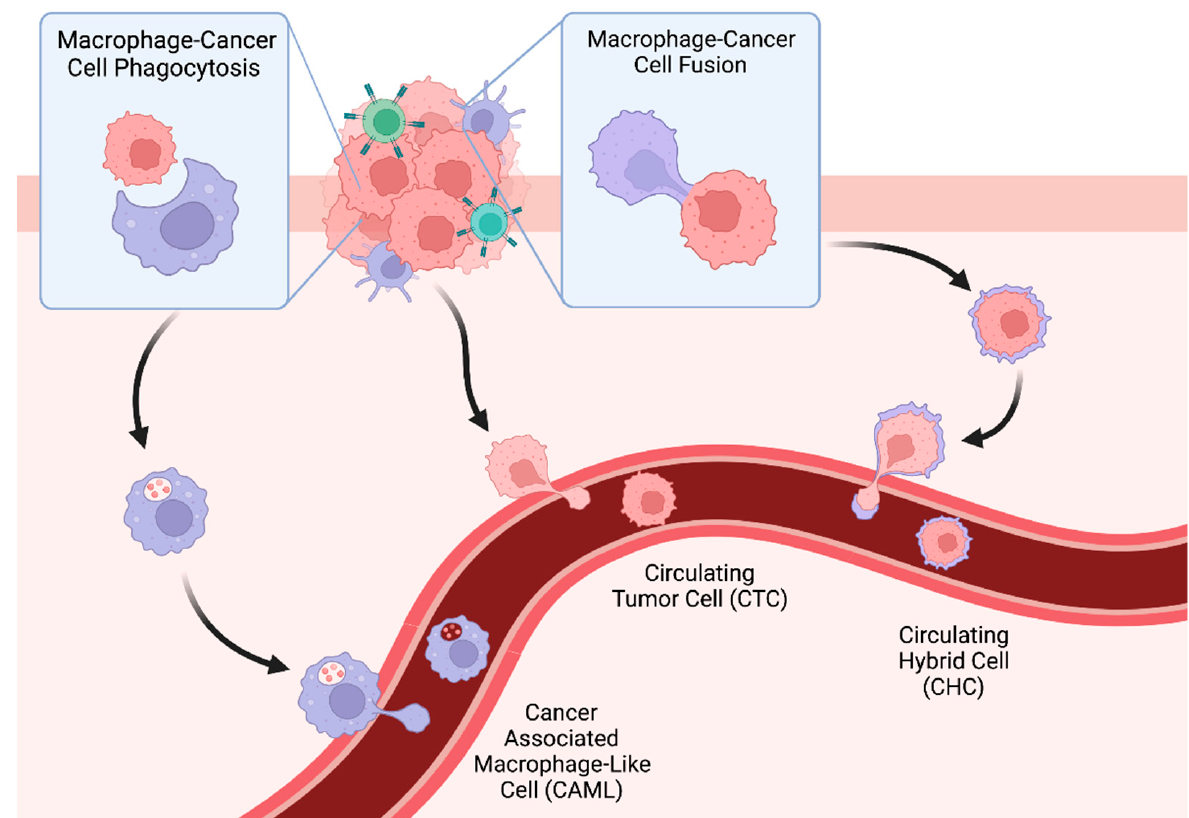
Figure 1. Circulating hybrid cells. CAMLs (immune cells), CTCs, and CHCs (neoplastic cells) are disseminated into peripheral blood from the tumor. Monitoring their presence in blood provides different information into the tumor evolution or response to therapy.